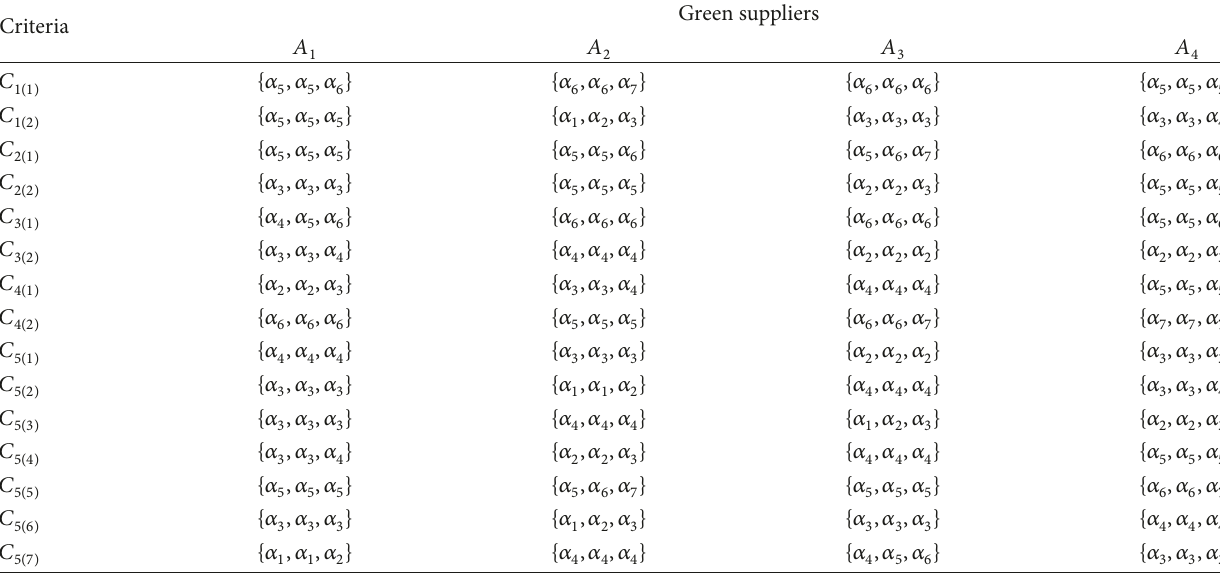
Table 3: The normalized HTrF evaluation results of green